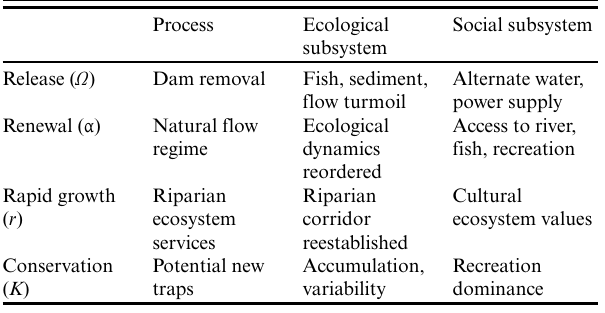
Table 1 . Dam decommissioning in relation to phases of river-SES adaptive